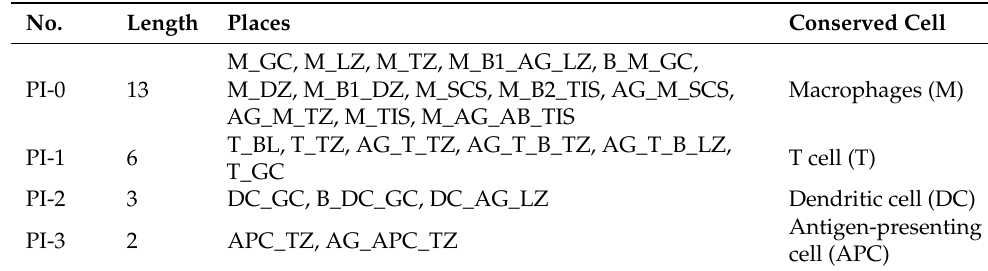
Table A4. List of four place invariants (PIs). The columns ”length”, ”places”, and ”conserved cell” provide the number of places of the PI, the names of all places of the PI, and the conservation of which cell (type) the PI originates from,